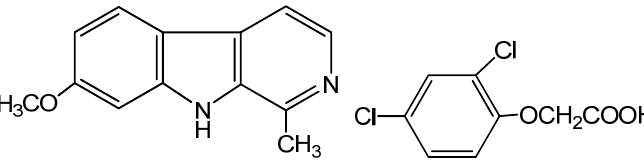
Figure 1. The structural formula of harmine and 2,4-D [(2,4-dichlorophenoxy)acetic acid].